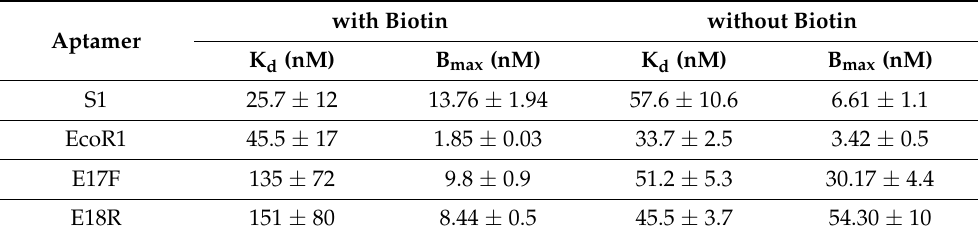
Table 4. K d and B max of aptamers with and without biotin tagged at 5 ′ end on E. coli O157:H7. Data represent Mean ± SD of 3 independent experiments.